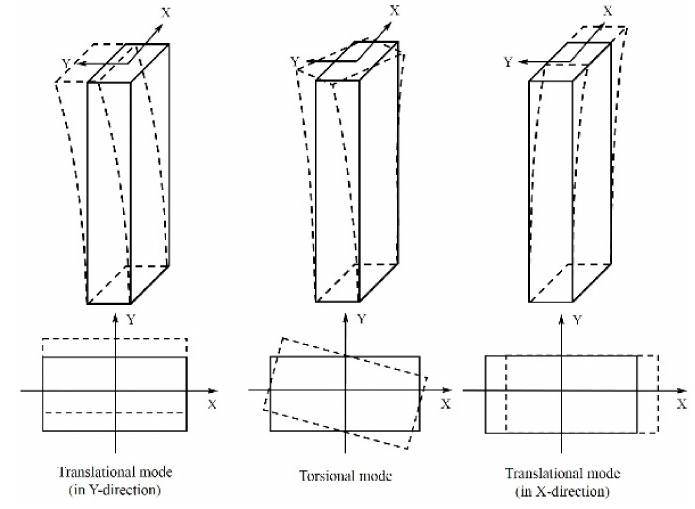
Figure 3. Building mode shape